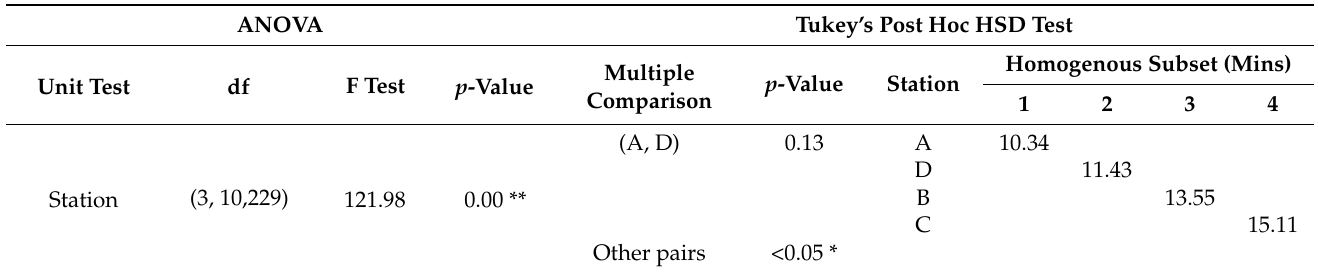
Table 4. Summary of ANOVA for mean response time and Tukey’s post hoc HSD